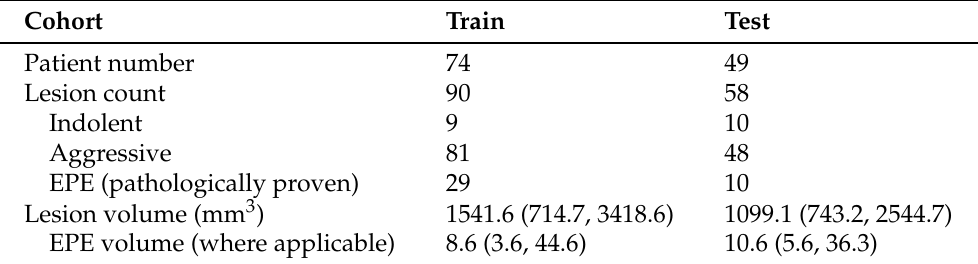
Table 2. Details of the train and test cohorts. Lesion volumes are presented as median (IQR), where IQR = interquartile range. Lesion volumes were computed based on the histopathology labels, assuming continuity between slices and using the MRI slice thickness.